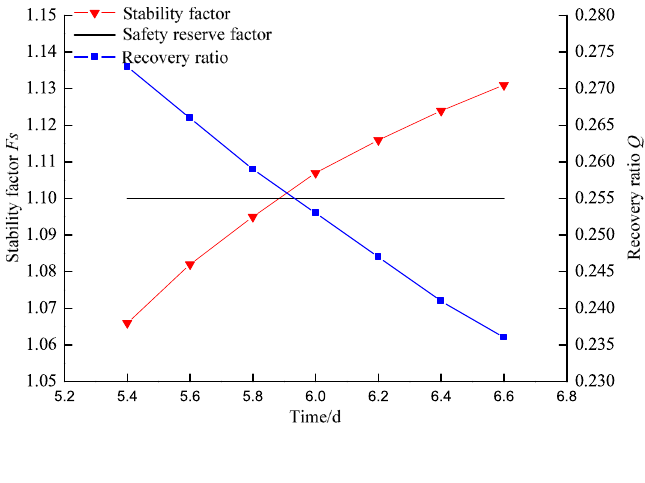
Figure 11. Stability coefficient and coal recovery rates for different coal pillar